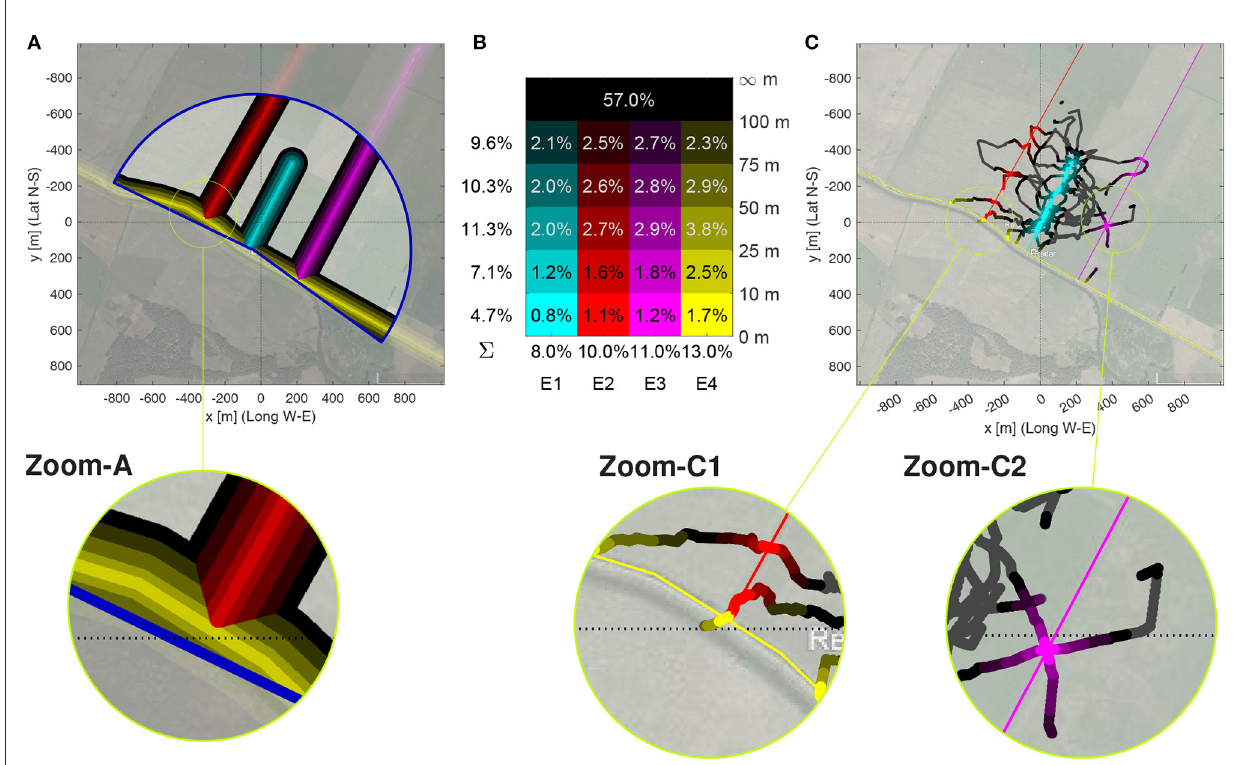
FIGURE8 Discrimination analysis based on time and flight angle near edges. (A) Pixels within the five distance ranges of 0 to 10m, 10 to 25, 50 to 75m, and 75 to 100m (color intensity coded) to one of the four edges (color coded). Color coding of closest edge and distance to edge as in (B) . The radar range is the blue bordered circular sector. Latitudidal and longitudinal coordinates are relative to the Release Site, Relative surface within the radar range covered by the distance ranges (rows) to each edge (columns E1–E4). The sums of the relative surface near each edge is shown below, the sums for each distance range on the left. Further away than 100m from any edge are 57% of the pixels. This figure also serves as legend for the color coding of the 4 5 distance ranges. (C) Flight path of Bee A05 with color-coding as in (B) of path segments when closer than 100m to an edge. The full path × is plotted as a black line.